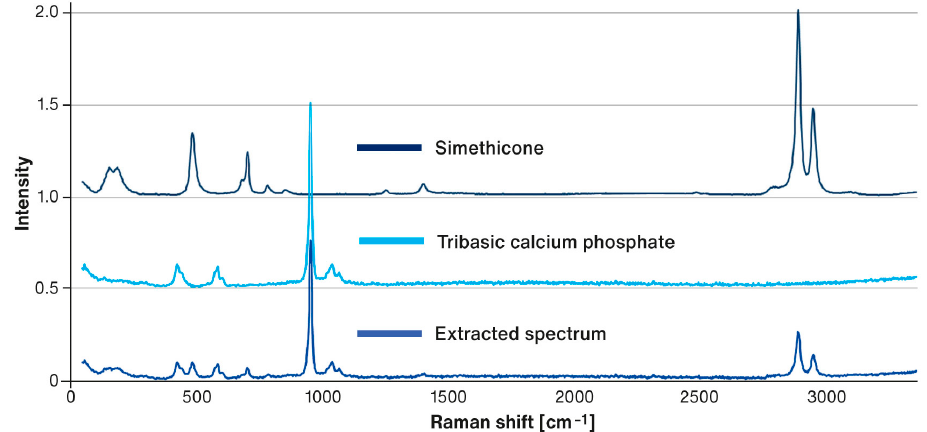
Figure 8. Raman spectra of simethicone, TCP, and an example of a spectrum recorded in the dark blue areas of the Raman correlation maps showing the superposition of individual Raman spectra.